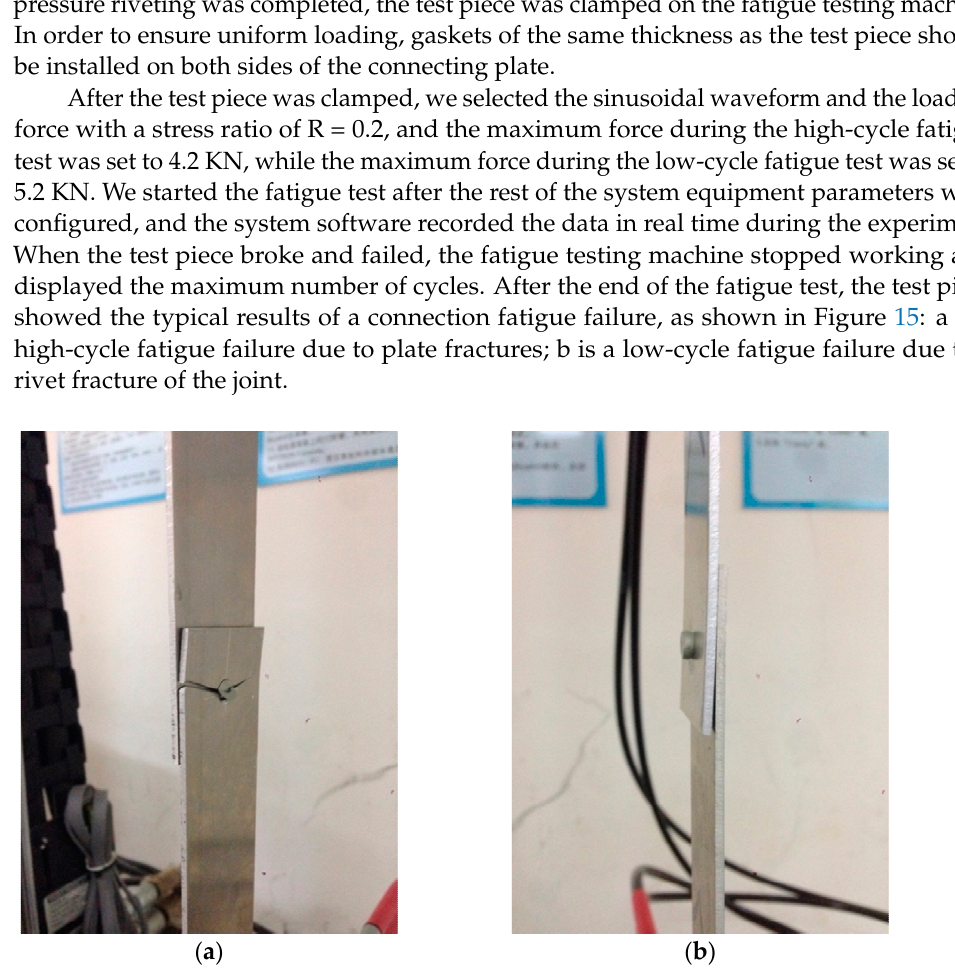
Figure 14. Schematic diagram of fatigue test system: Instron 8872 Fatigue Test System.